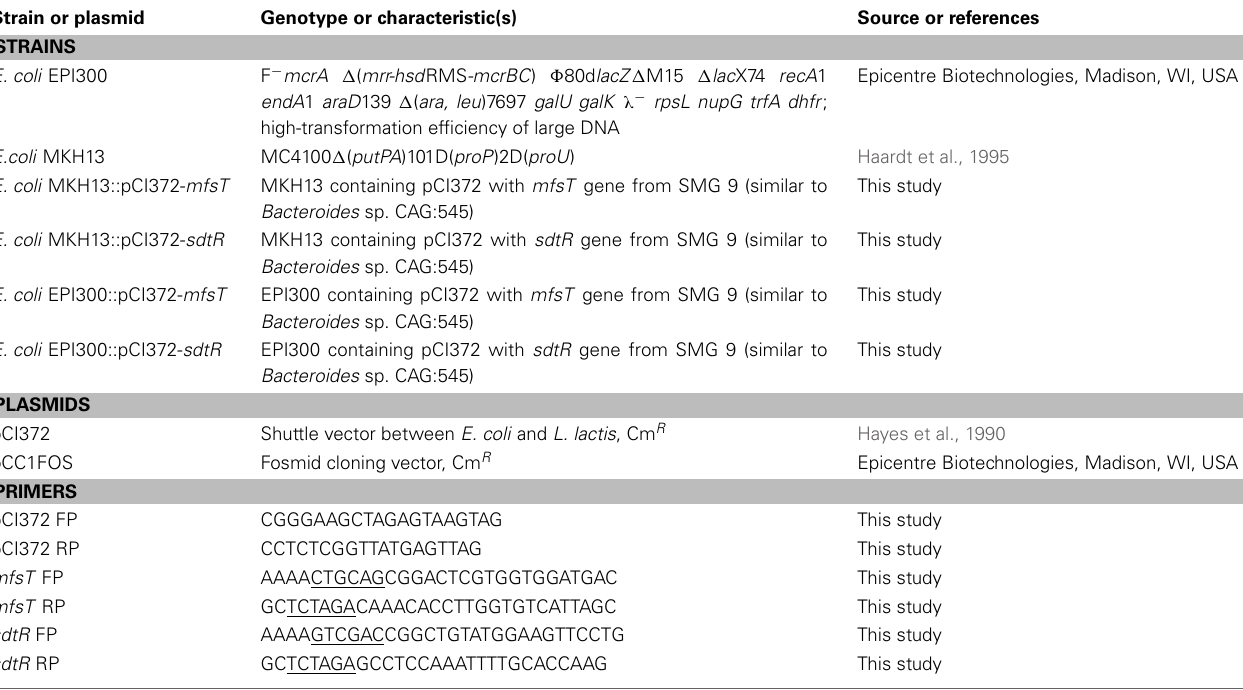
Table 1 | Bacterial strains, plasmids and oligonucleotide primers used in this study. Strain or plasmid Genotype or